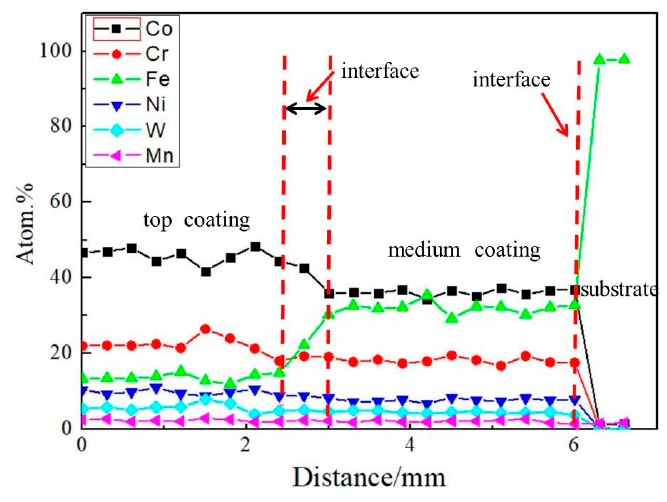
Figure 4. The distribution of elements in cross-section of coating B.